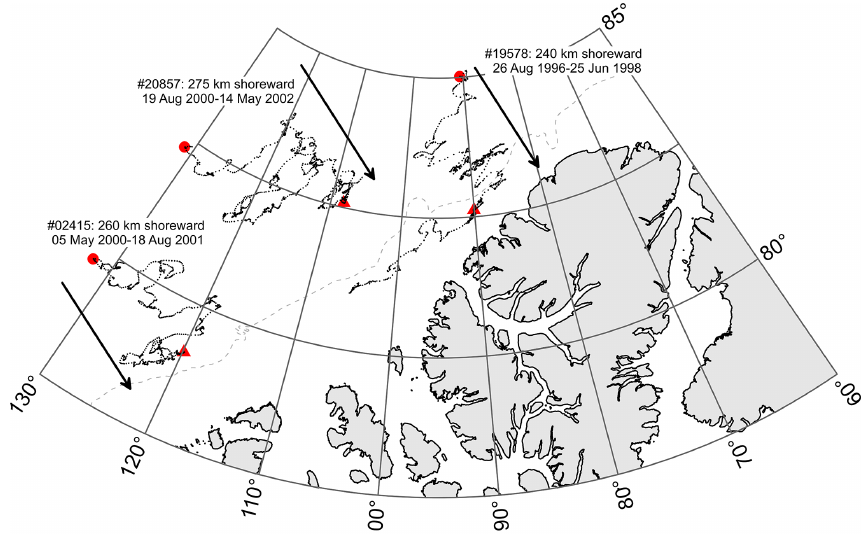
Figure 14. Tracks of three beacons on ice northwest of the Canadian Arctic Archipelago, illustrating the combined shearing and compressive deformations that allow the ice slowly to approach the coast. The starting and ending points are marked by red dots and triangles, respectively. Data courtesy of the International Arctic Buoy Programme (http://iabp.apl.washington.edu/index.html, last access: 2 August